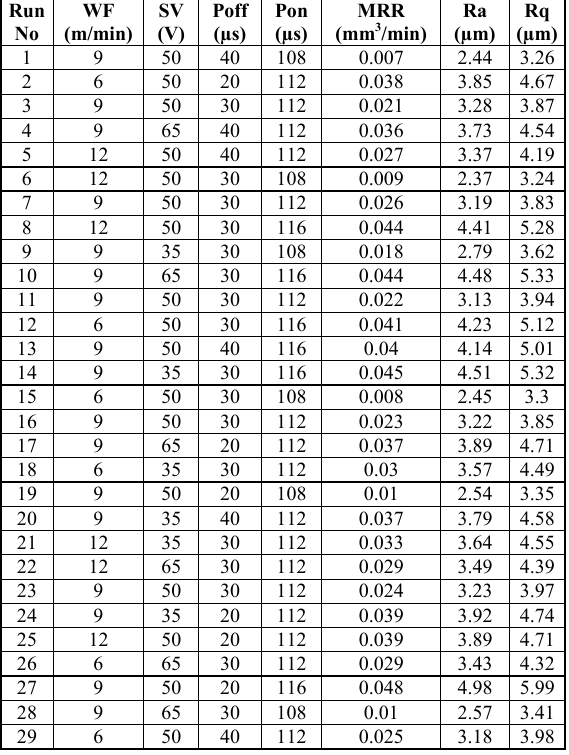
Table 1. Experimental matrix and